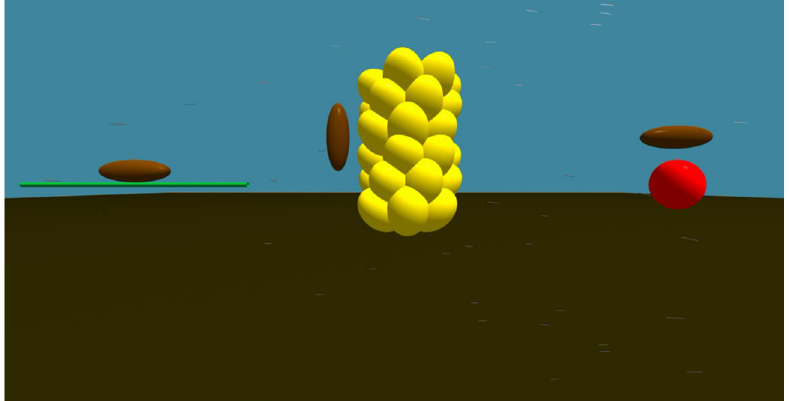
Fig 3. Assumptions for heat budget estimation of WCSBs. Left: WCSB on a needle. Center: WCSB on male cones. Right: WCSB on a female